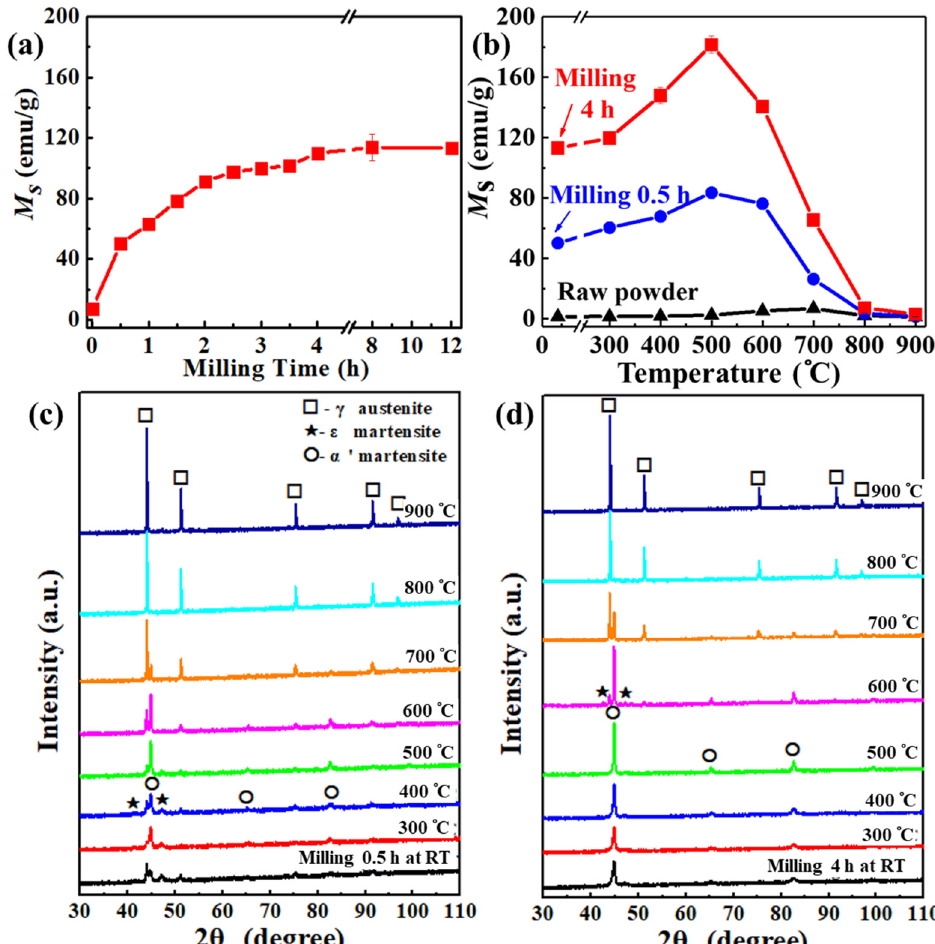
Figure 2. Evolution of M S in FeCoCr powders during ( a ) ball milling and ( b ) subsequent heat treat- ment; XRD spectra of FeCoCr powders ( c ) after ball milling for 0.5 h and subsequent heat treatment and ( d ) after ball milling for 4 h and subsequent heat treatment.